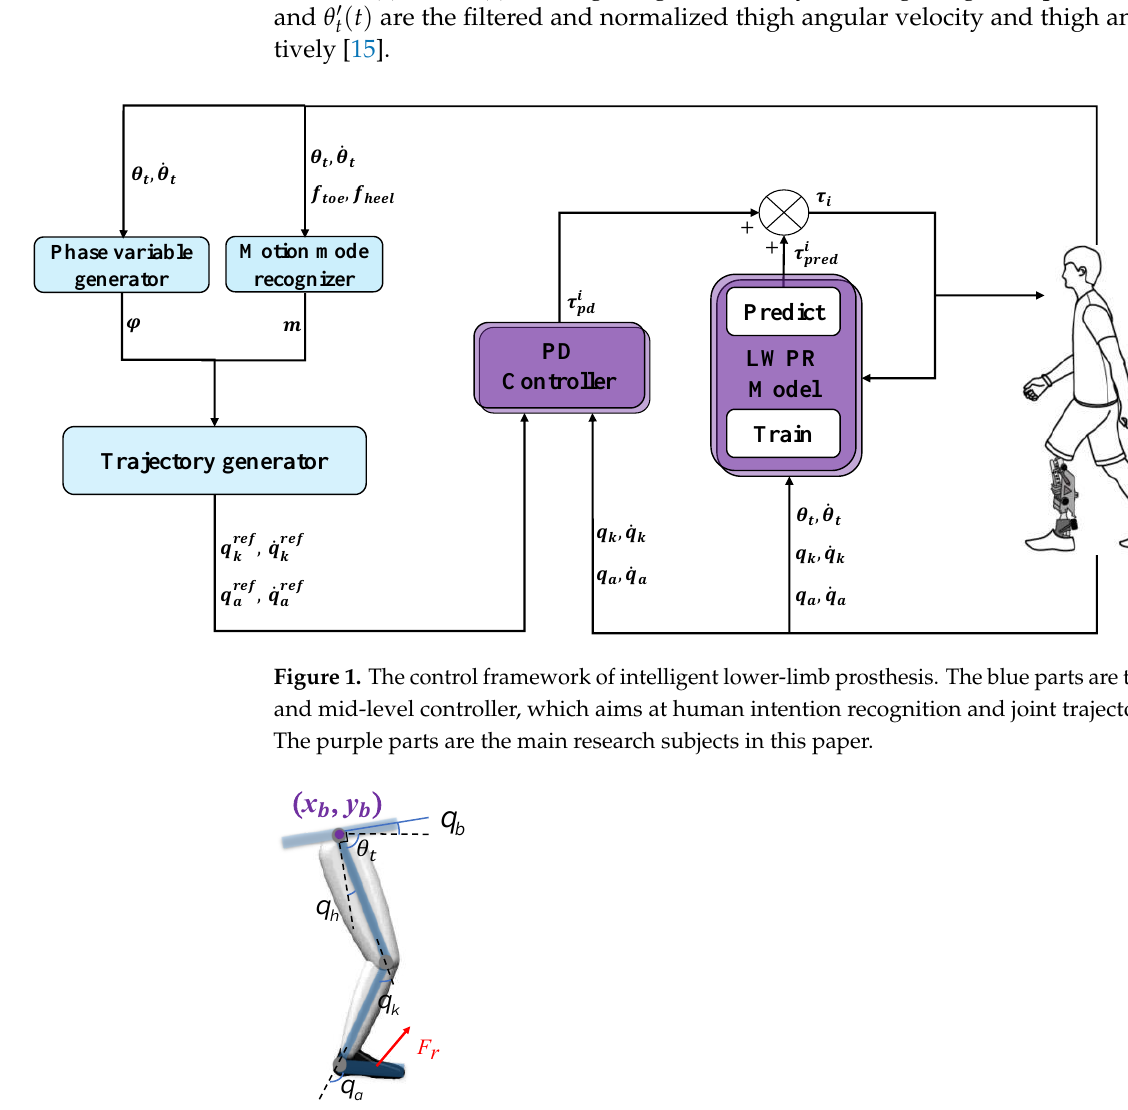
Figure 2. The simplified lower-limb prosthesis model.